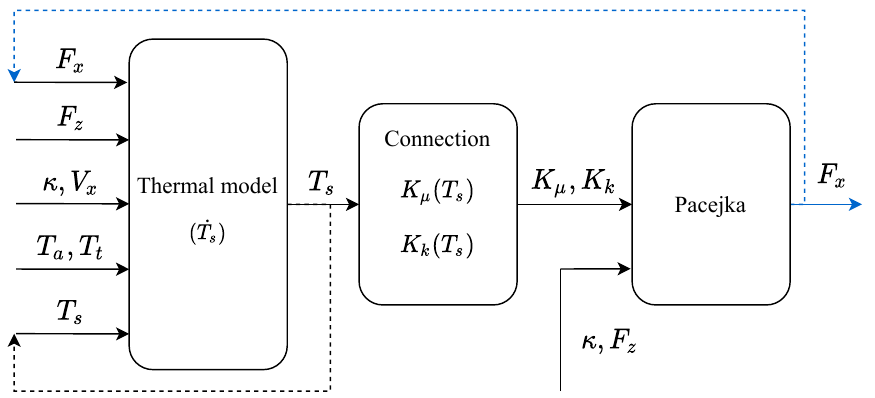
Figure 2. Total thermal tyre model schematic with data